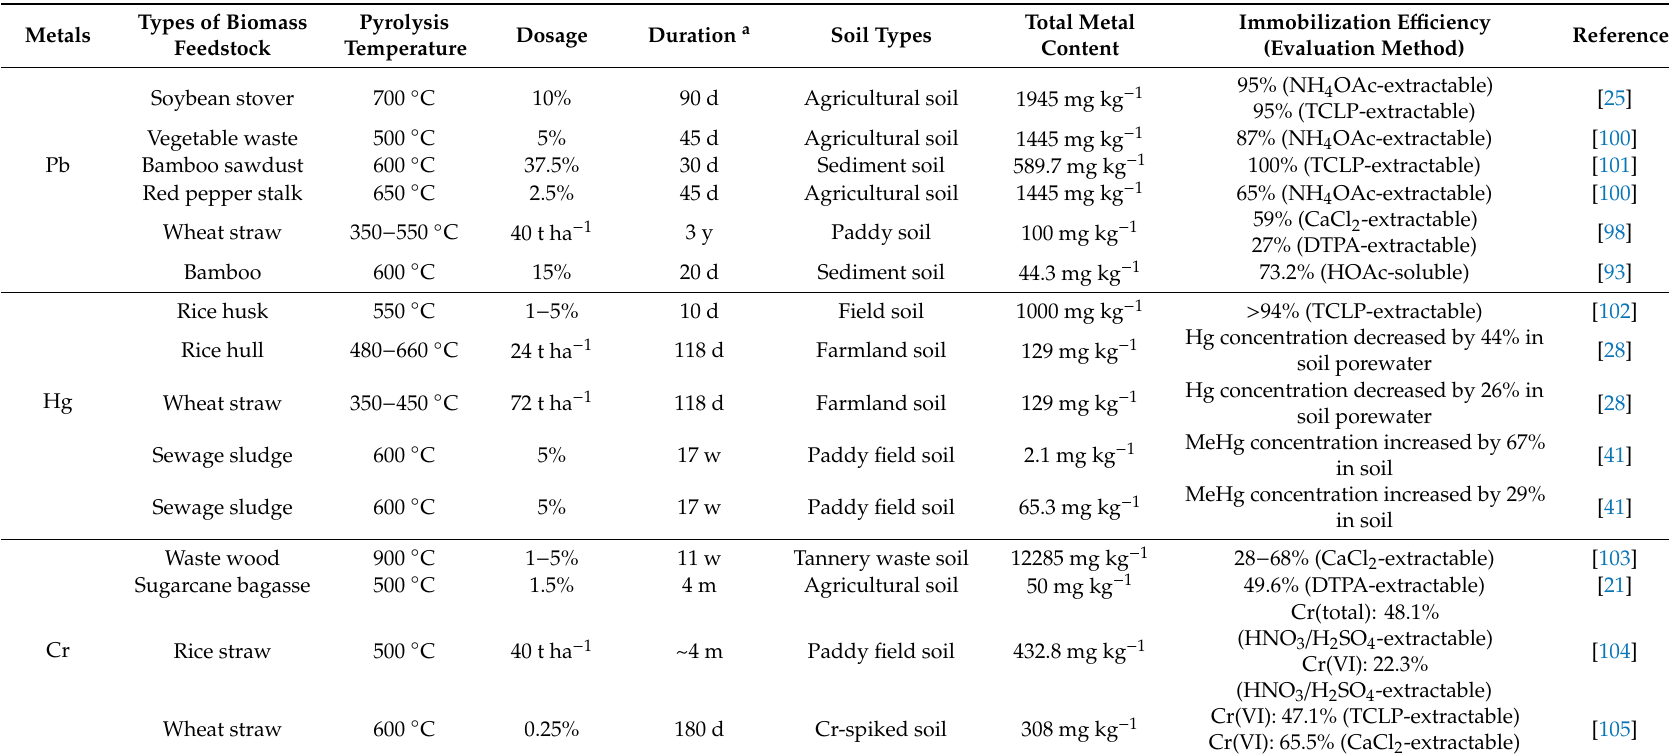
a Units explanation: d for days, w for weeks, m for months and y for